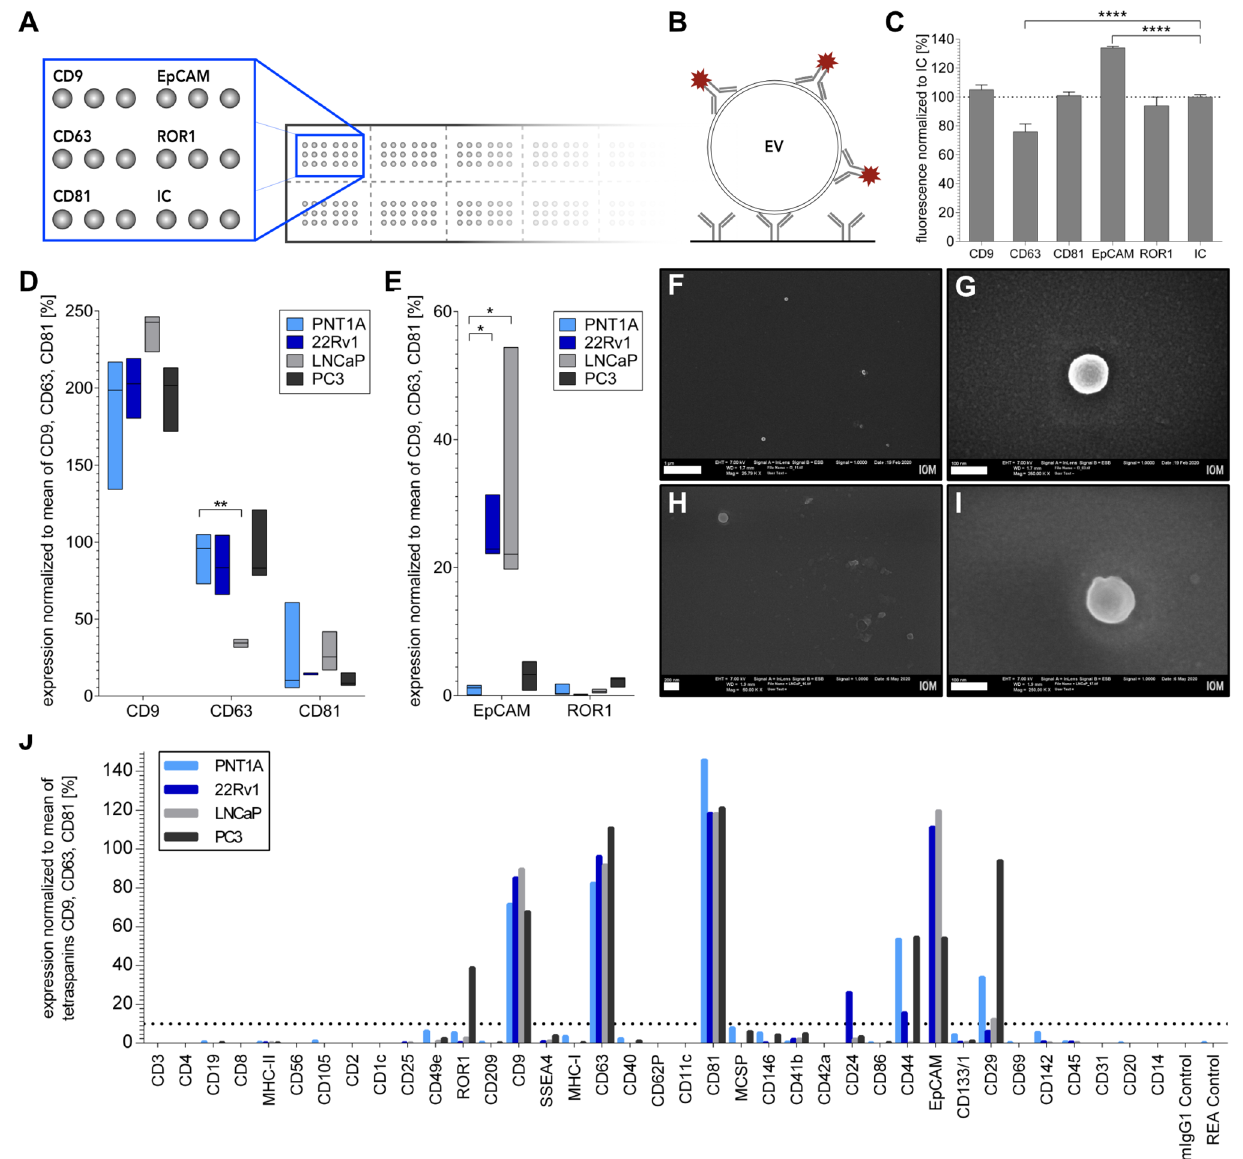
Figure 5. Characterization of EV surface proteins from ultrafiltrated supernatants with an in-house spotted antibody microarray, showing the design of antibodies spots on the functionalized glass slide ( A ) to bind EVs, that will be detected by APC-labeled anti-CD9, -CD63 and -CD81 antibody ( B ). Immobilization of the spotted antibodies observed by Cy3-labeled anti-mouse antibody normalized to the isotype control (IC) ( C ). Results of 1E + 10 particles of UF from PNT1A, 22Rv1, LNCaP and PC3 supernatants after 24 or 30 h serum- free incubation in triplicate of CD9, CD63 and CD81 ( D ) as well as EpCAM and ROR1 captured EVs ( E ) normalized to the mean of all three detection antibodies (n = 3 ± SD). SEM imaging of signal positive spots from 22Rv1 ( F,G ) and LNCaP ( H,I ) of 25 k and 50 k fold magnification with scale bars of 1 µm and 200 nm, respectively (left) and 250 k magnification with scale bars of 100 nm (right). UF from PNT1A, 22Rv1, LNCaP and PC3 after 24 or 30 h serum-free incubation analyzed with the commercially available MACSPlex Exosome Kit (n = 1). Values are normalized to the mean of the detection tetraspanins CD9, CD63 and CD81 ( J ). Statistical analysis was performed using one-way ANOVA with a P value equal ≤ 0.05 *, ≤ 0.01 * and ≤ 0.0001 Compared to UF, reduced protein and particle numbers were found for UC, followed by SEC and DG. There are many factors that should be considered. Currently, it is unclear how a high g-force during ultracentrifuga- tion might affect EV stability and function, since EV aggregation after ultracentrifugation has been described 42 . Another aspect is, that our results indicate a higher EV purity after DG followed by SEC or UC compared to UF, as also noticed by TEM. There are still some open questions, for instance how many EVs are lost during the isola- tion process and which subpopulations are being analyzed. Without a suitable method that quantifies the entire EV population, it is not possible to accurately assess the EV yield after isolation. Despite of this, other groups have proposed the use of fluorescent EV-like particles as spike-in controls to overcome this issue 43–45 . The EV